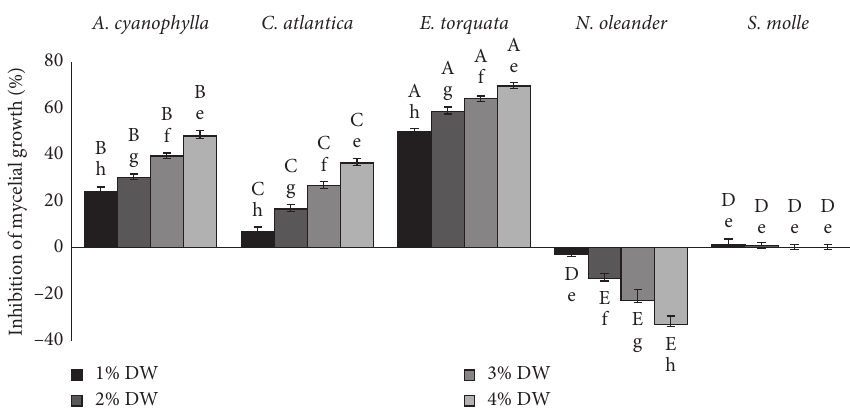
Figure 1: Effect of different plant DW percentages on M. scaettae mycelial growth. Plant species and extract concentration had significant effects on the percentage of radial growth inhibition (one-way ANOVA, p < 0 . 05). Each bar represents the mean of four replicate plates per concentration. Within each plant species, bars followed by the same lowercase letters indicate no significant differences among extract concentrations, while within each concentration, bars followed by the same uppercase letters indicate no significant differences among plant species (Bonferroni tests, p < 0 . 05). Error bars represent standard errors.